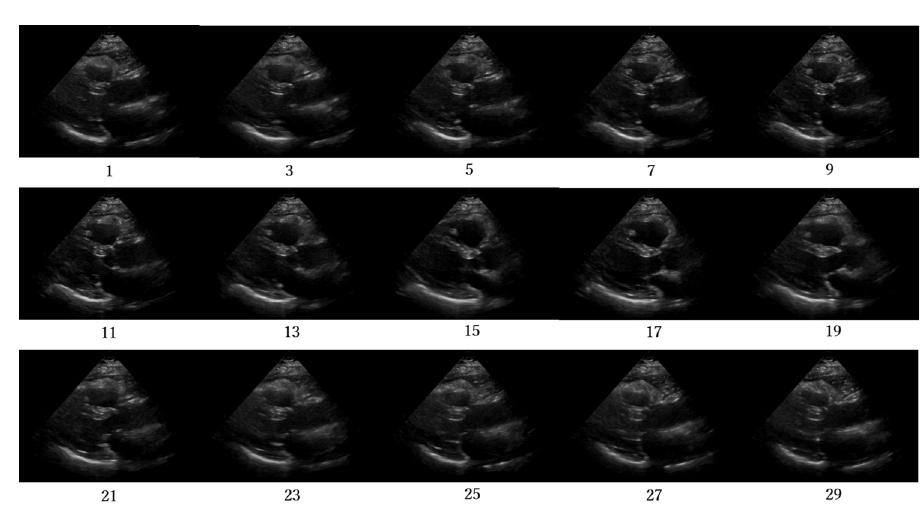
Fig 16. False-positive cases on long-axis view images.